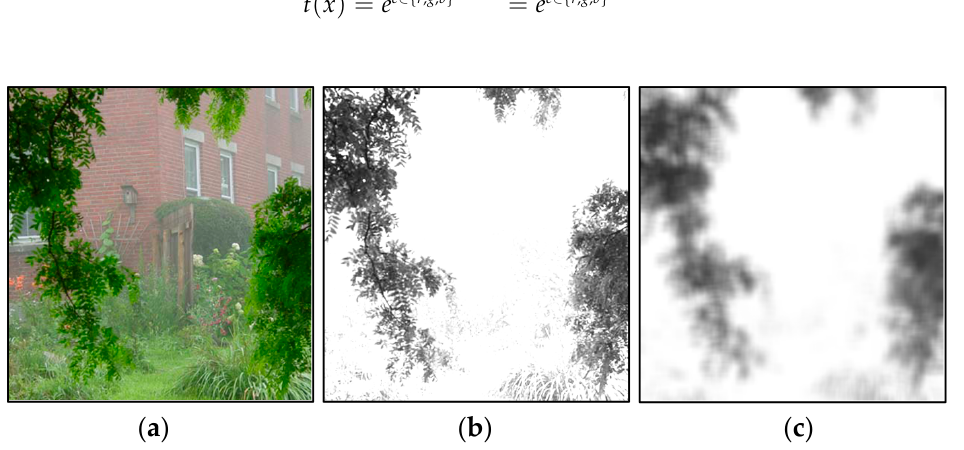
Figure 4. Initial value of the atmospheric light. ( a ) Input hazy image; ( b ) The value of Y ( x ) ; and ( c ) the blurred Y ( x ) , namely the initial value of atmospheric light.